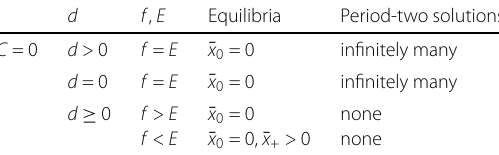
Table 2 Existence of equilibria and period-two solutions for a > 0, f > 0, C = 0